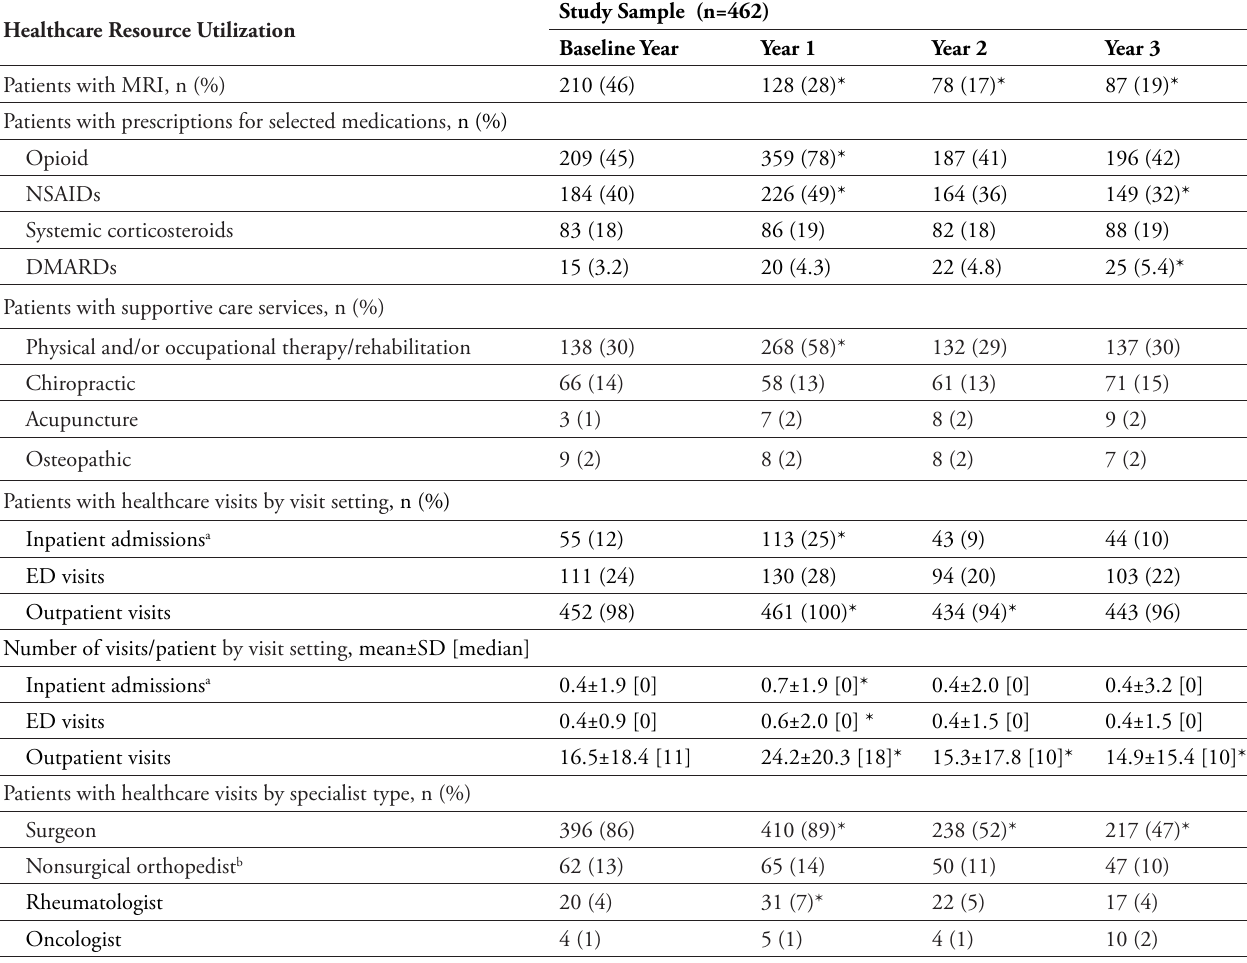
Table 2. Healthcare Resource Utilization in Patients with TGCT Who Underwent Joint Surgery Healthcare Resource